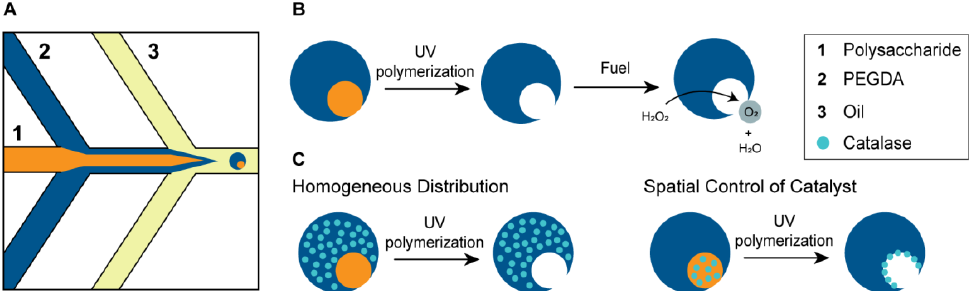
Figure 1. Schematic representation of the experimental design. ( A ) Close-up of the ATPS-based microfluidic chip to generate droplet-in-droplet morphology. An aqueous-two-phase jet is formed at the first cross junction, which is emulsified at the second cross junction by a surfactant containing oil. ( B ) Asymmetric microgels are obtained after UV-polymerization of the droplets generated by the microfluidic chip; upon addition to hydrogen peroxide the catalyst, catalase, will decompose the fuel to water and propelling oxygen. ( C ) Two methods to position the catalyst, either homogeneously through incorporation in the gel or spatially through adding it to the polysaccharide, templating